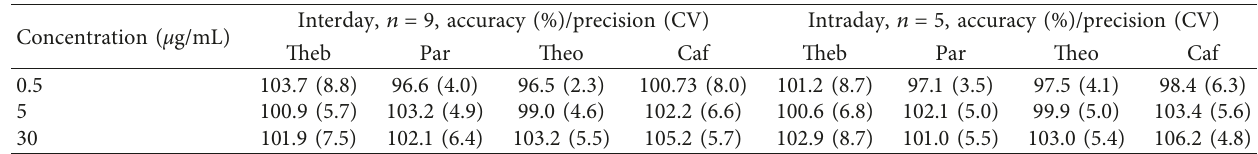
Figure 3: Typical calibration curves for quantification of theobromine (a), paraxanthine (b), theophylline (c), and caffeine (d) in human plasma. Theobromine (- ○ -), paraxanthine (- ◆ -), theophylline (- ◊ -), and caffeine (- ▲ -). Table 2: Results of intra- and interday variability during validation of the HPLC method. Accuracy is expressed as percentage of the nominal value. Precision is expressed in terms of the percentage of the coefficient of